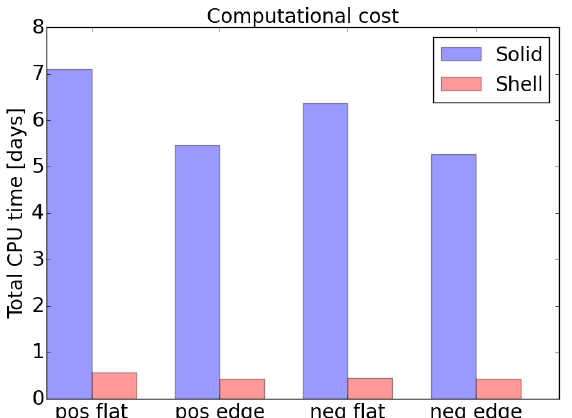
Figure 17. Comparison between the computational costs for the different load cases for the final shell and solid models considered in this study. The CPU time required to calculate the shell models is less than 10% of that for the solid models. The analyses were parallelized over multiple CPUs.